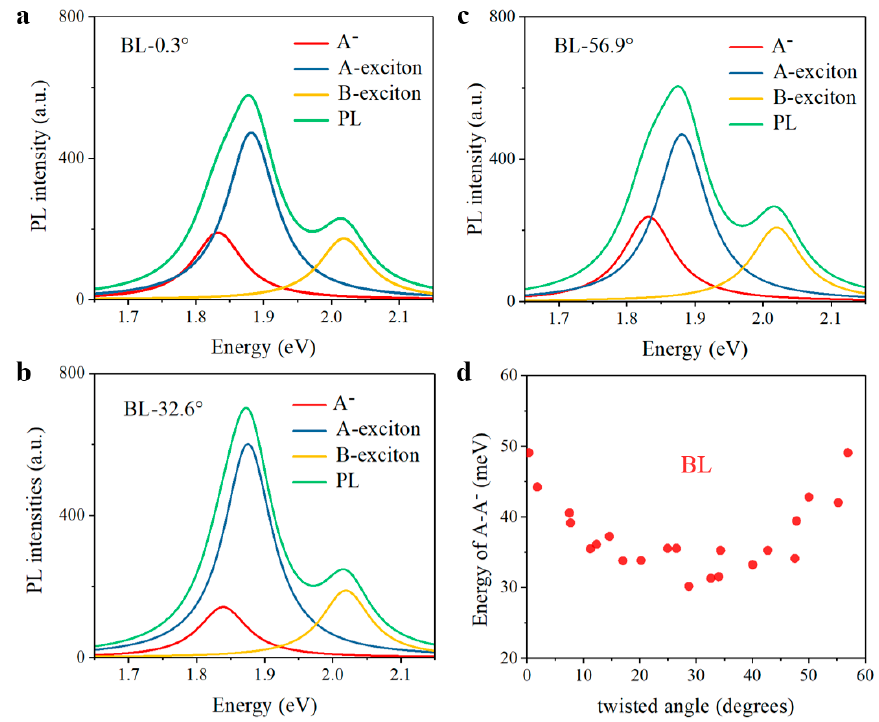
Figure 3. PL spectra of twisted MoS 2 bilayers. ( a – c ) PL spectra of ( a ) 0.3°, ( b ) 32.6° and ( c ) 56.9° twisted MoS 2 bilayers. ( d ) Trion binding energies collected in different twisted bilayers from 0° to 60°. BL, normal bilayer; A - , trion.